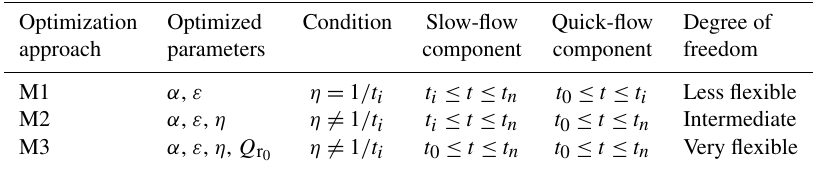
Table 2. Optimized recession parameters for the three different parameters of the optimization approaches (POAs) of the Mangin recession analysis